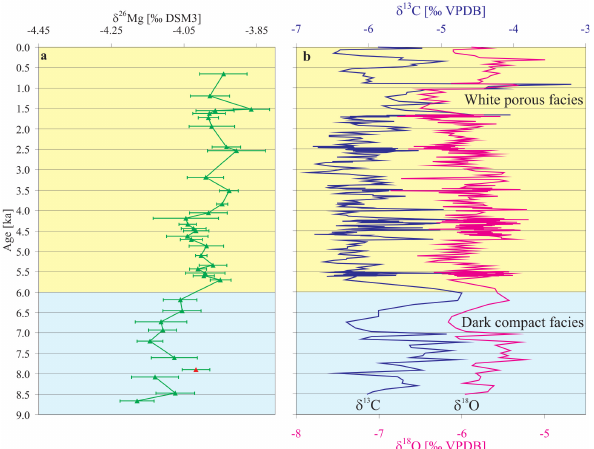
Fig. 3. Magnesium, carbon and oxygen isotope data of the stalag- mite AH-1 from Atta Cave, Germany. (a) Mg-isotope data plotted against age in ka BP using the StalAge model of Scholz and Hoff- mann (2011). Red triangle indicates sample taken in a detritus layer. (b) Carbon (dark blue) and oxygen (magenta) isotope data plotted against age in ka BP (data from Niggemann et al., 2003). Portions of the speleothem characterized by a dark compact facies are shown in blue; those characterized by a white porous facies are shown in yellow.